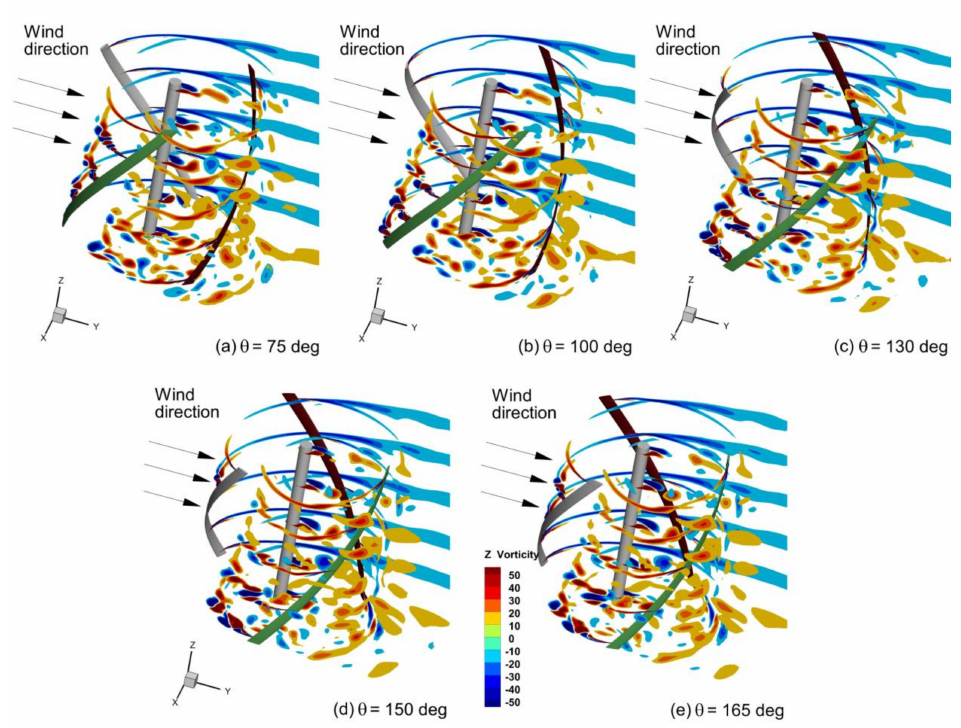
Figure 18. Z-vortex magnitude for 90 ◦ helical VAWT at z planes at heights of − 1.45 m, − 0.75 m, 0 m, 0.75 m, and 1.45 m at azimuth angles of rotation of ( a ) 75 ◦ , ( b ) 100 ◦ , ( c ) 135 ◦ , ( d ) 150 ◦ , and ( e ) 165 ◦